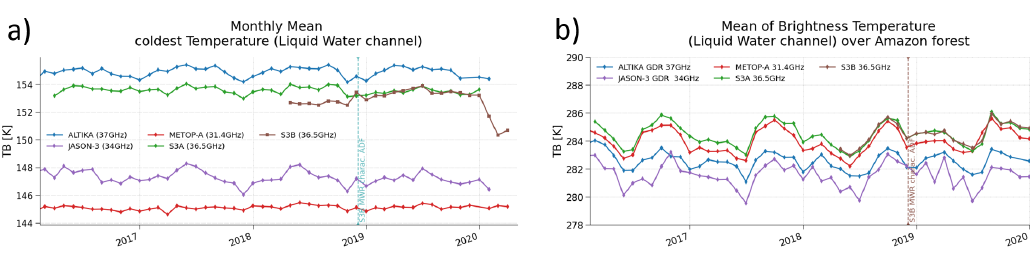
Figure 12. Monitoring of ( a ) Cold reference and ( b ) Hot reference for 36.5 GHz channel of S3A and